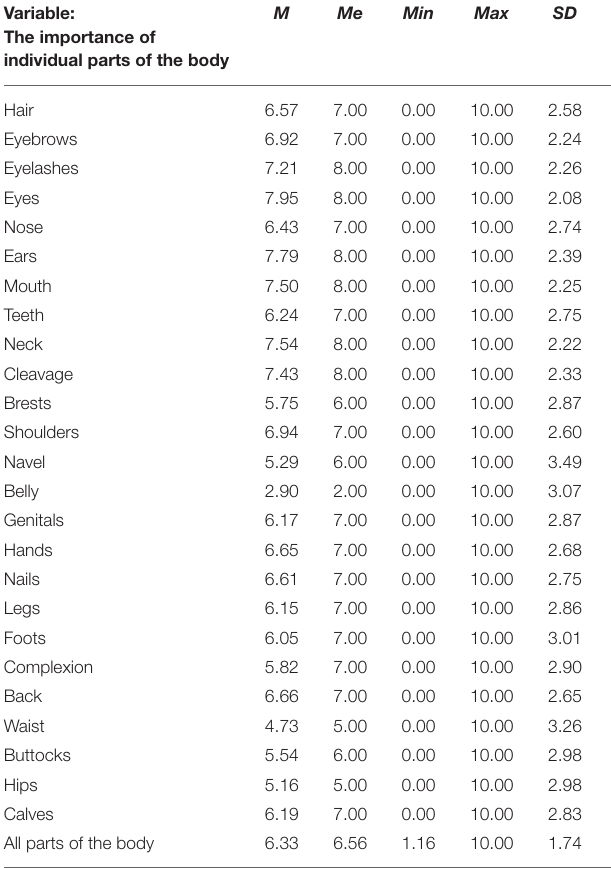
TABLE 7 | Descriptive characteristics of means in terms of importance level assessment, i.e., focus on individual parts of the body in women diagnosed with DRAM ( n = 345).